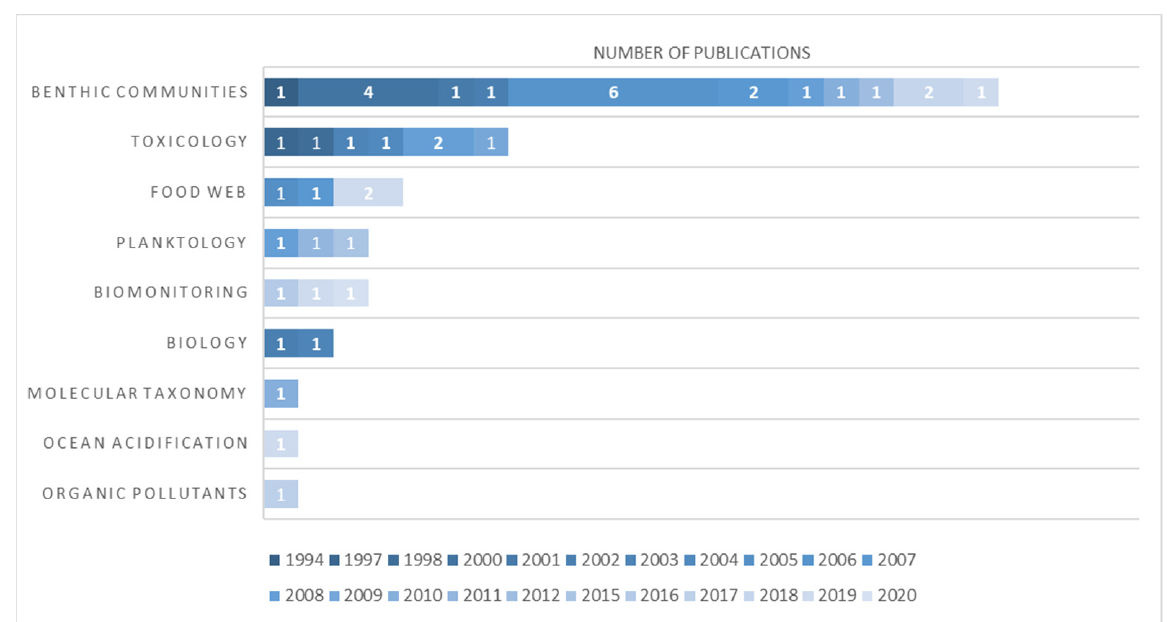
Figure 8. Graphical ranking representation of the 43 publications analyzed for this work in Terra Nova Bay area. Each paper was classified into a general category. The publications are color-coded based on the year of publication (which runs from 1972 to 2020). The data refer to available literature in February 2022.